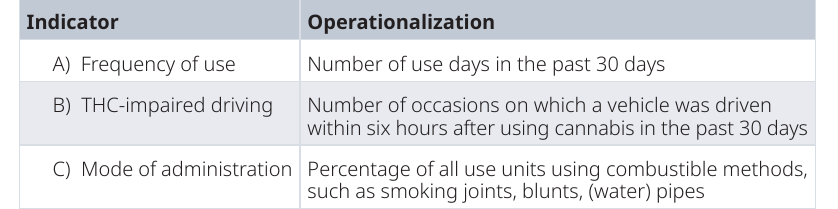
Table 1. Operationalization of secondary outcomes.